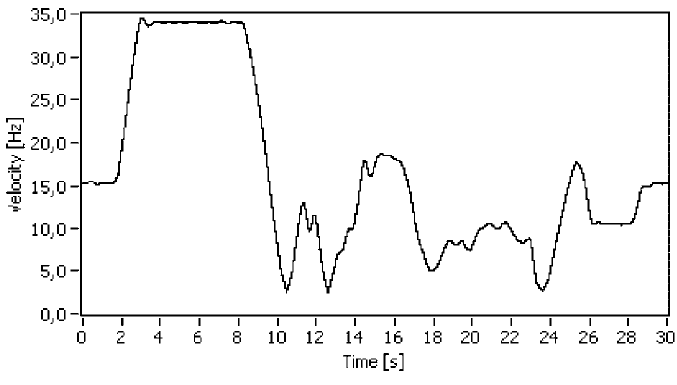
Fig. 15. Speed variation of the hoist transmission of a mining